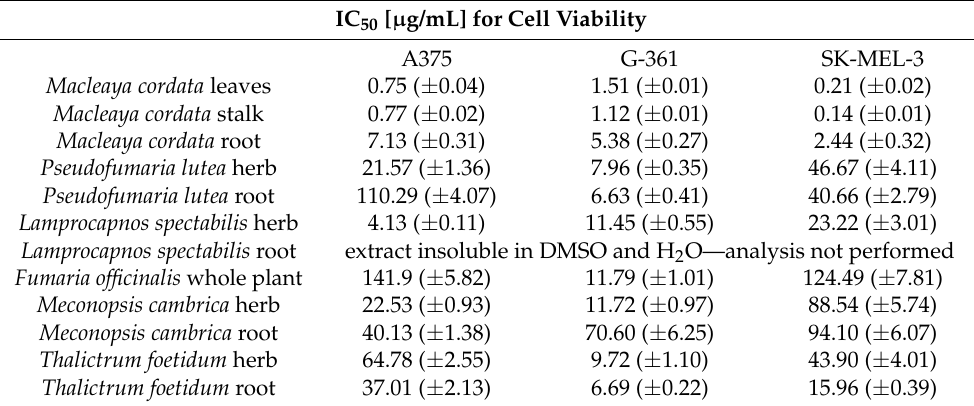
Table 5. Cytotoxic activity expressed as IC 50 values of the investigated extracts against melanoma cell lines (A375, G-361,